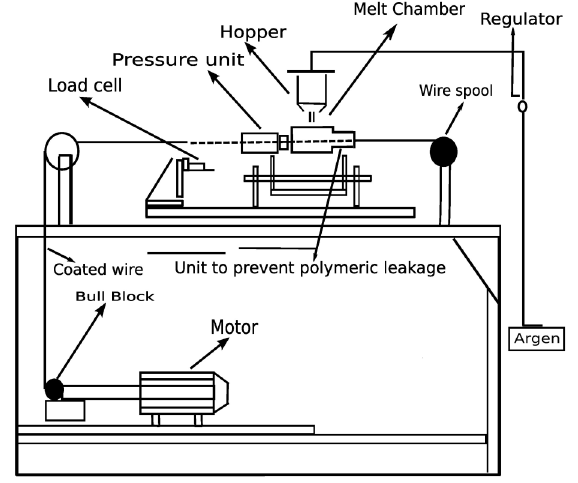
Figure 1. Typical wire coating line.